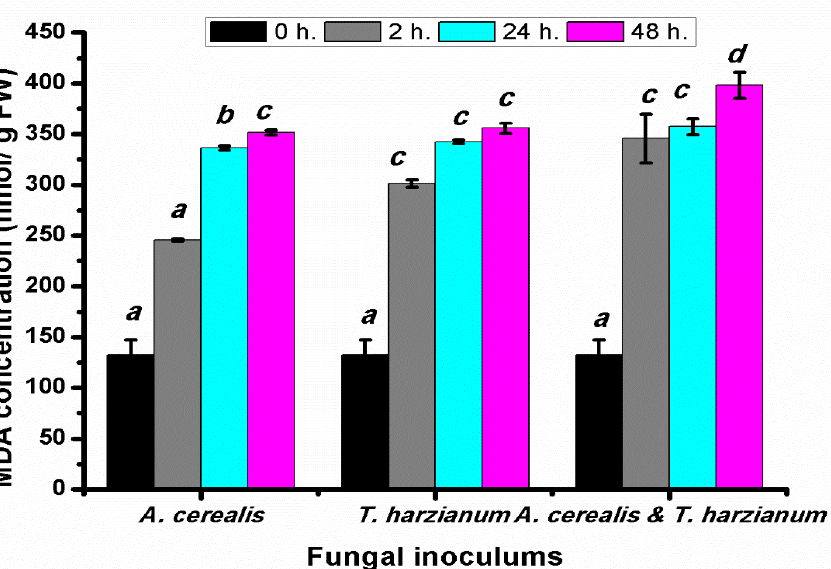
Figure 10. MDA (nmol/ g FW) of tomato leaves ( S. lycopersicum L.) under the effect of pathogen ( Alternaria cerealis MT808477), and pathogen inhibitor ( Trichoderma harizainum ) after 0, 2, 24, 48 h of inoculation, data are means ± SD ( n = 3), with statistically significant differences ( p < 0.05).